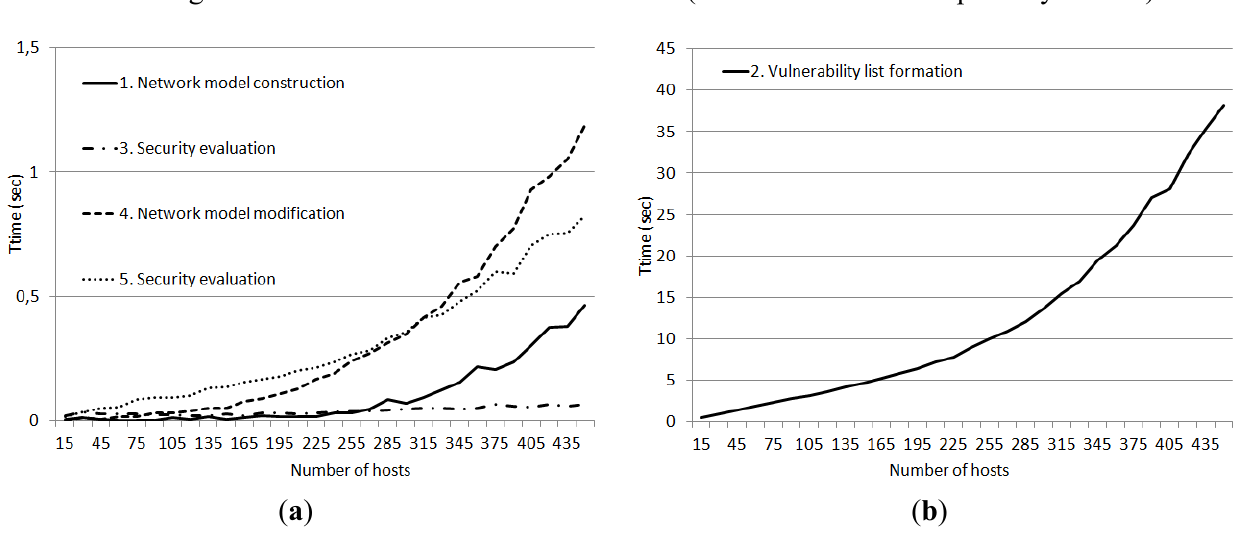
Figure 11. Dependency between the time (sec) required for different steps of AMSEC functioning and the amount of hosts in the network (when the relational repository is